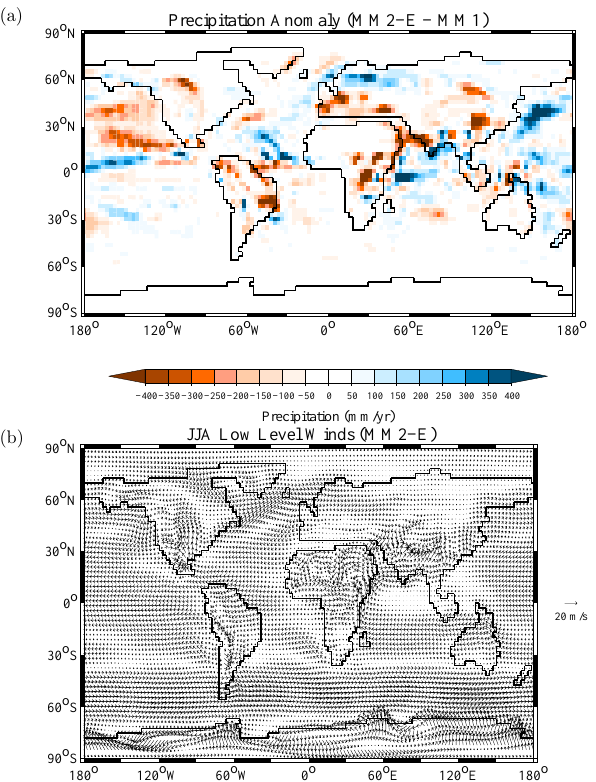
Fig. 11. Low-level winds (850hPa) for the MM2 experiment in (a) Northern Hemisphere summer and (b) Northern Hemisphere winter.